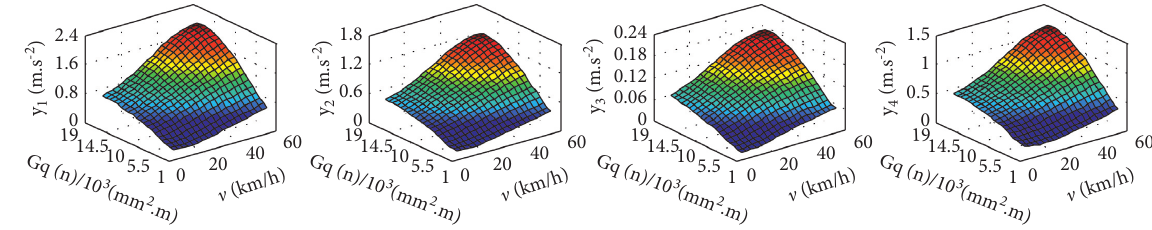
Figure 25: Kriging approximate model fitting.